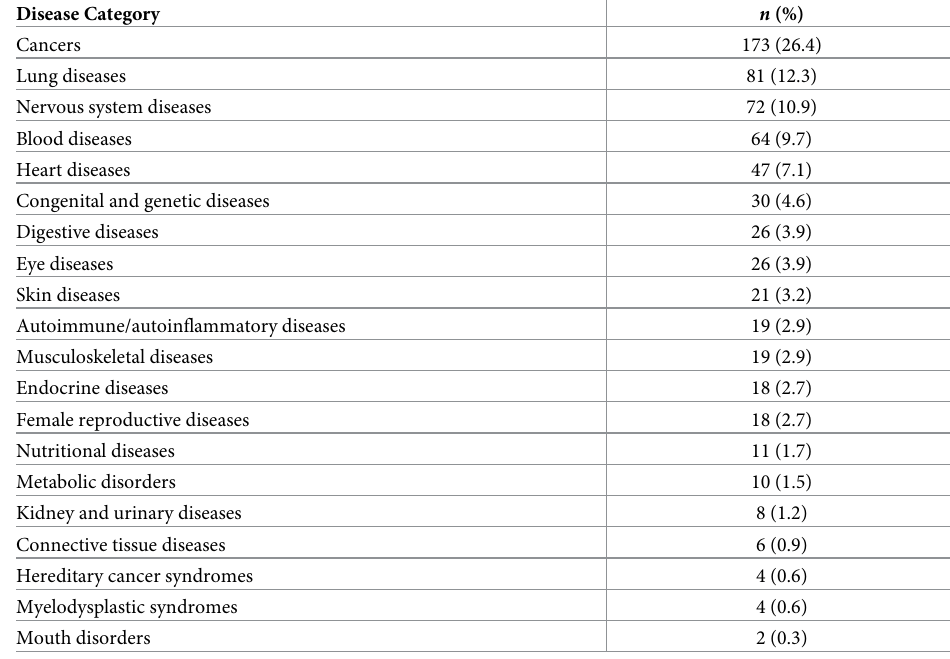
Table 1. Disease categories for 659 randomized clinical trials studying rare diseases. Disease